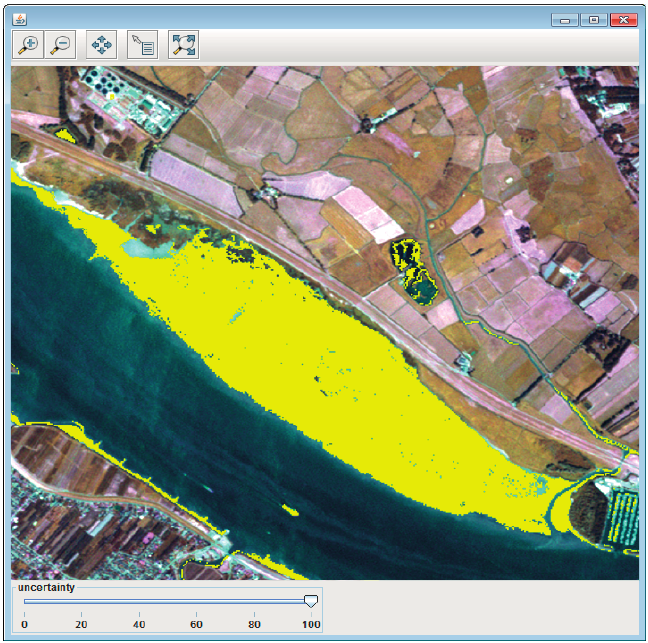
Figure 10. Software prototype for iterative filtering by